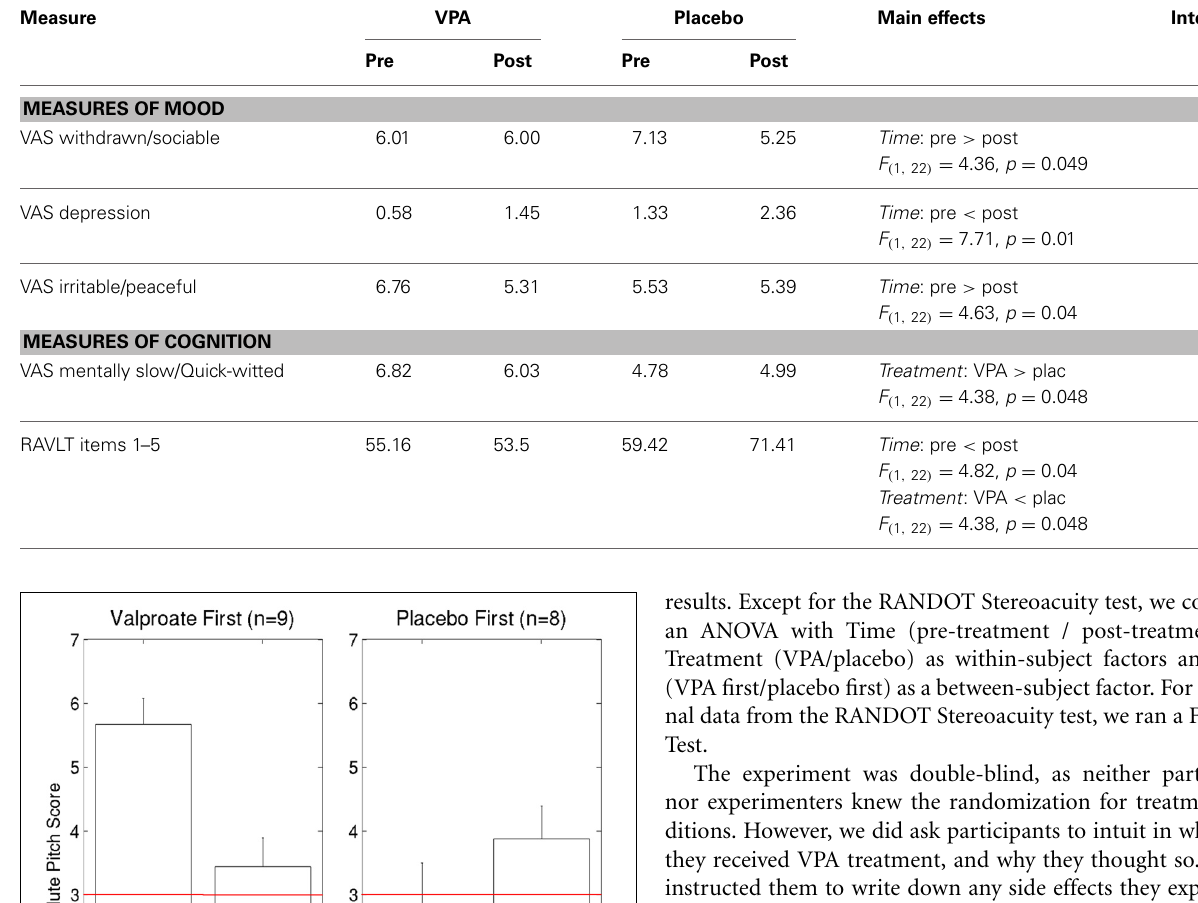
Table 2 | Analysis of mood and cognitive measures in the first treatment arm.